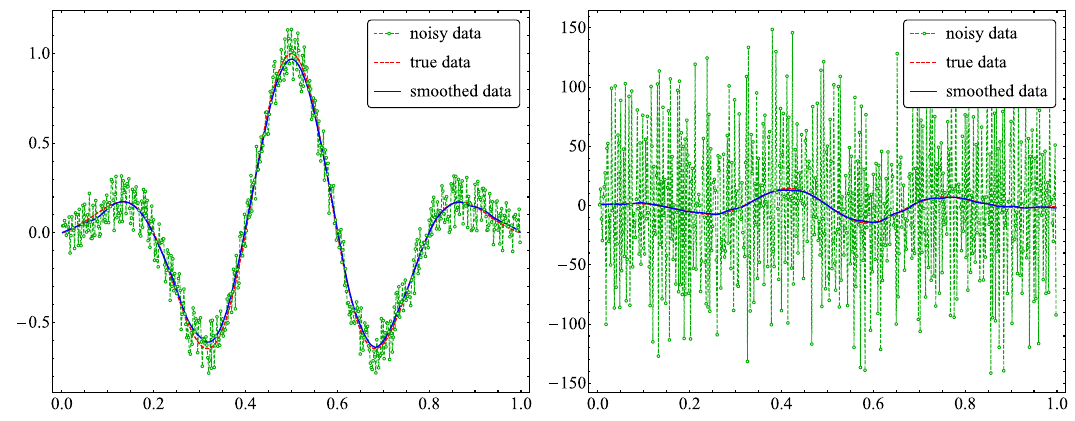
Figure 1: Data ( left ) and the corresponding derivative ( right ) for Example 5.1.